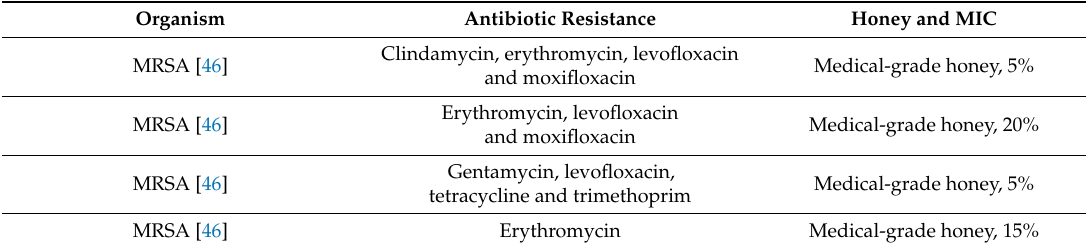
Table 3. Examples of bacterial resistance and the e ffi cacy of